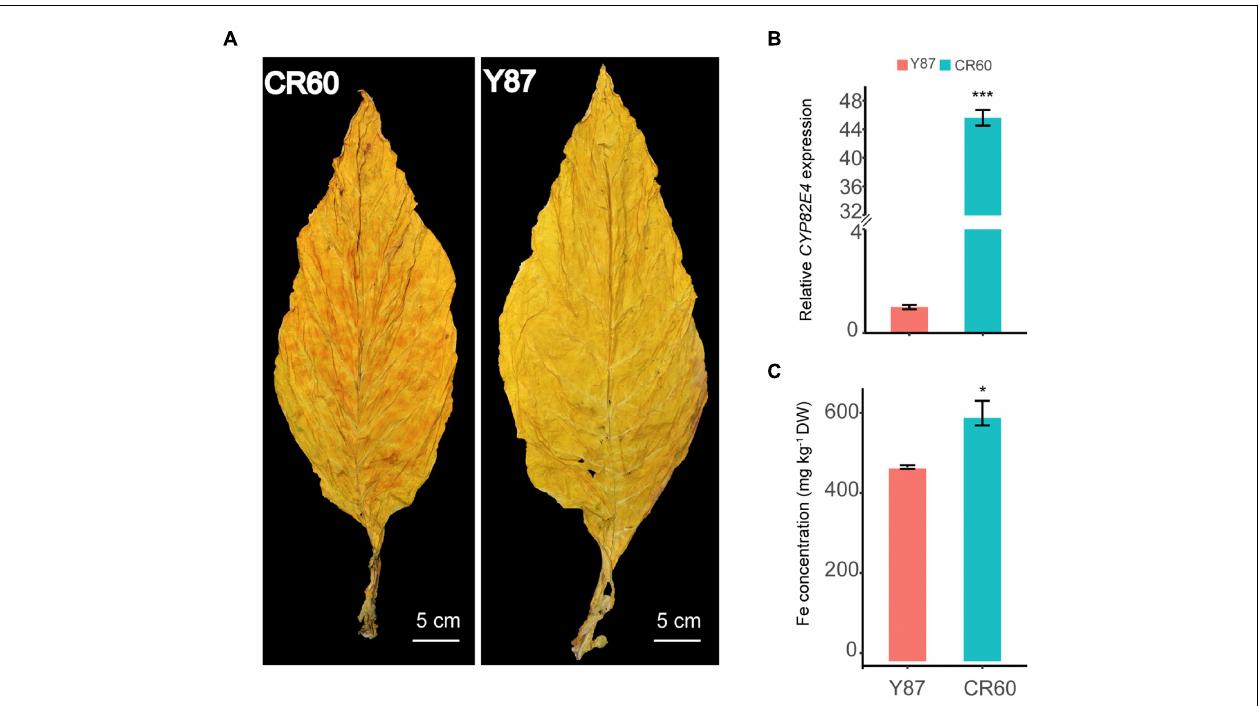
FIGURE 1 | Differential appearance of flue-cured leaves (A) , expression of CYP82E4 gene (B) and Fe concentrations (C) in leaves of CR60 and Y87. The plants were cultivated in an experimental field located at the Yanhe Research Farm of Yunnan Academy of Tobacco Agricultural Sciences, Yunan Province, China (N24.14, E102.30, altitude 1,680 m). For panel (A) the matured leaves were harvested and flue-cured following local agricultural practices. For panel (B) , leaves at stalk position #10 (from top to bottom) of 2-month-old plants were harvested for RNA isolation. For panel (C) the 5th to 10th (from top to bottom) leaves were flue-cured and mixed for ICP-MS analysis. Three biological replicates were analyzed. Values are means ± SD ( n = 3). Asterisks indicate significant differences between the CR60 and Y87 plants (* P < 0.05 and *** p < 0.001) as determined by the Student’s t -test.